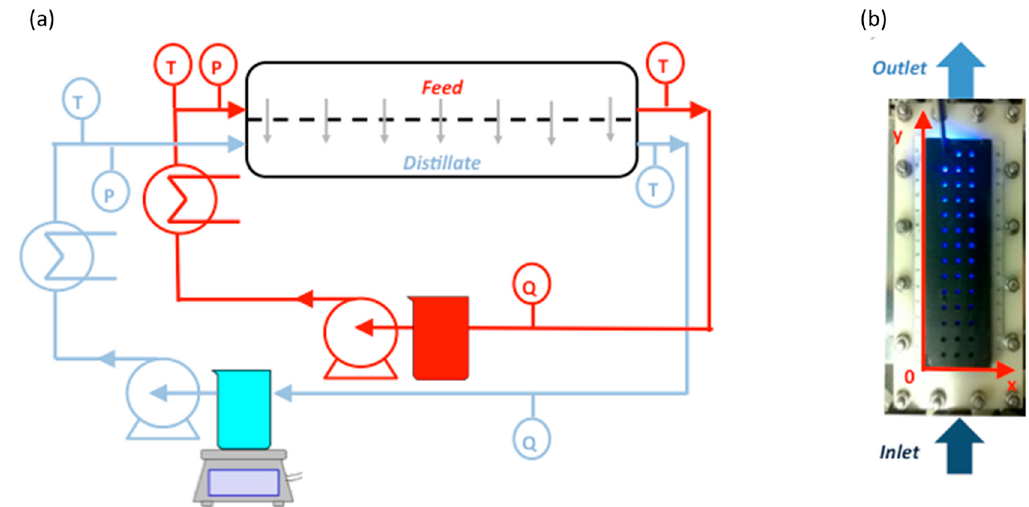
Figure 2. ( a ) Scheme of the set-up employed for DCMD test equipped with sensors for monitoring the temperature (T), the flow rate (Q), and the pressure (P) of the feed and the distillate; ( b ) Picture of the membrane module developed for optical observation.